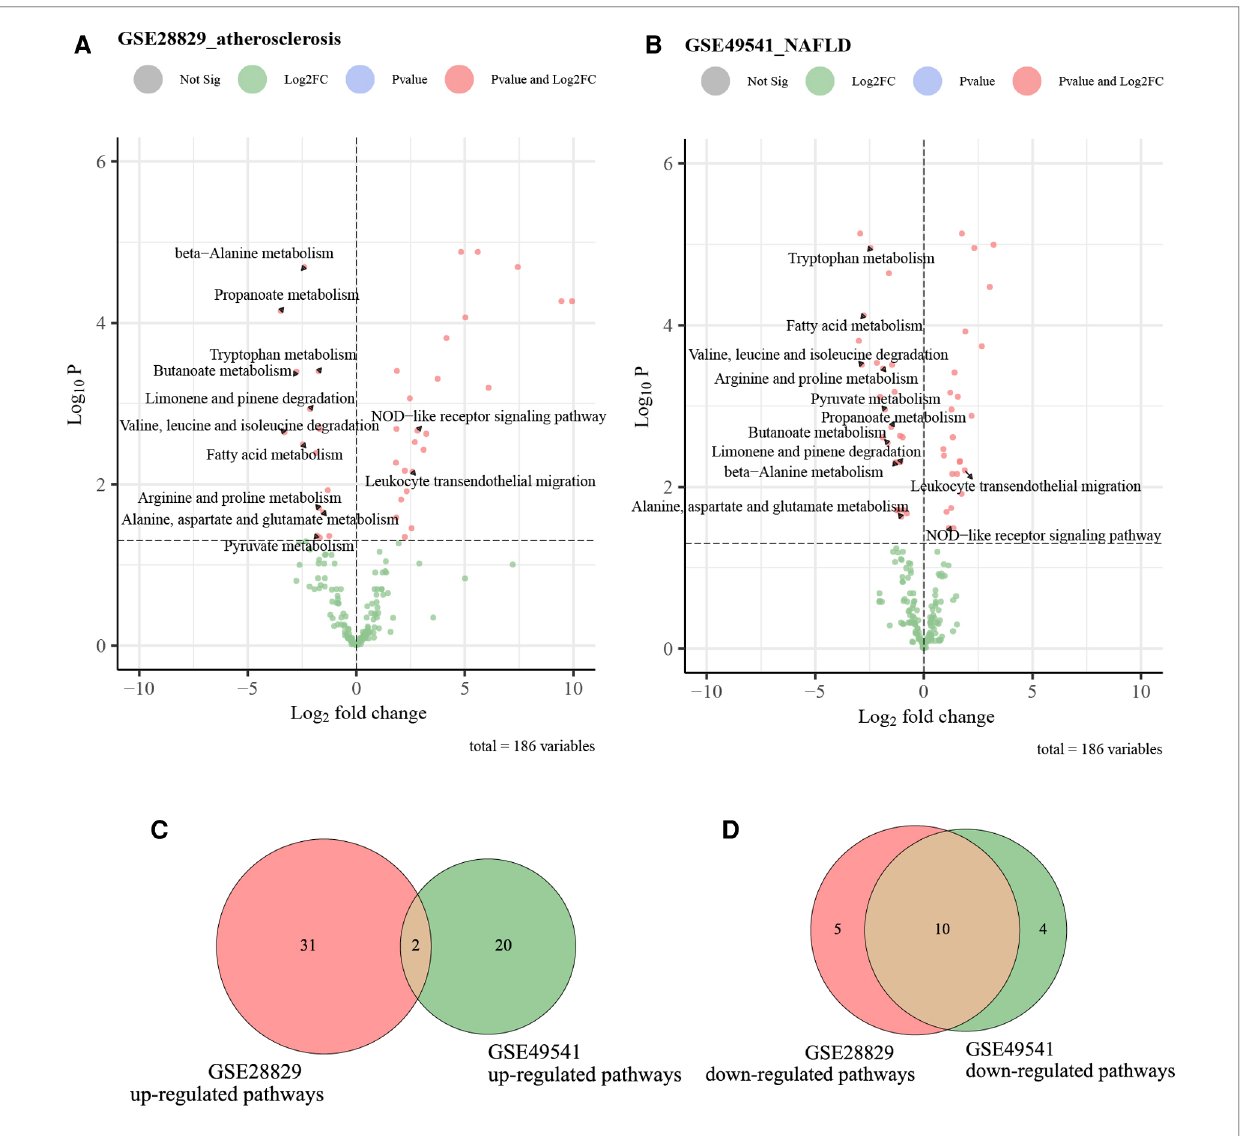
FIGURE 10 The volcano plots and Venn diagrams for identifying co-regulated pathways. ( A ) The volcano plot of up-regulated and down-regulated pathways in GSE28829; ( B ) the volcano plot of up-regulated and down-regulated pathways in GSE49541; ( C ) the Venn diagram of common up-regulated pathways between GSE28829 and GSE49541; ( D ) the Venn diagram of common down-regulated pathways between GSE28829 and